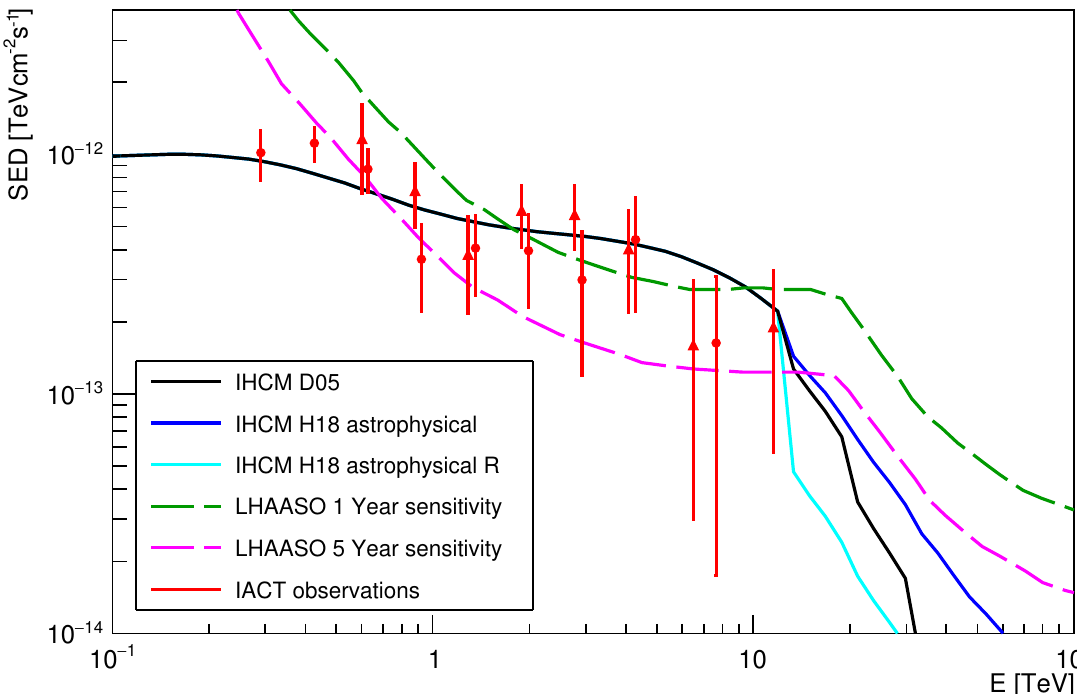
Figure 5. Comparison of IHCM model SEDs of the blazar 1ES 0229+200 inside the PSF of LHAASO experiment (the PSF was taken from [57] for energies E > 10 TeV; for lower energies an integral SED is used) with SEDs measured by H.E.S.S. [51] and VERITAS [52] as well as LHAASO sensitivity curves. Solid lines denote model SEDs: blue line corresponds to astrophysical R (H18) model of EGMF, cyan line—to astrophysical (H18), and black line—to D05. Dashed lines denote 1-year (green line) and 5-year (magenta line) sensitivities of the LHAASO experiment particle detector. Finally, symbols with error bars denote IACT measurements of the observable SEDs of 1ES 0229+200: red dots correspond to VERITAS measurements, red triangles—H.E.S.S.